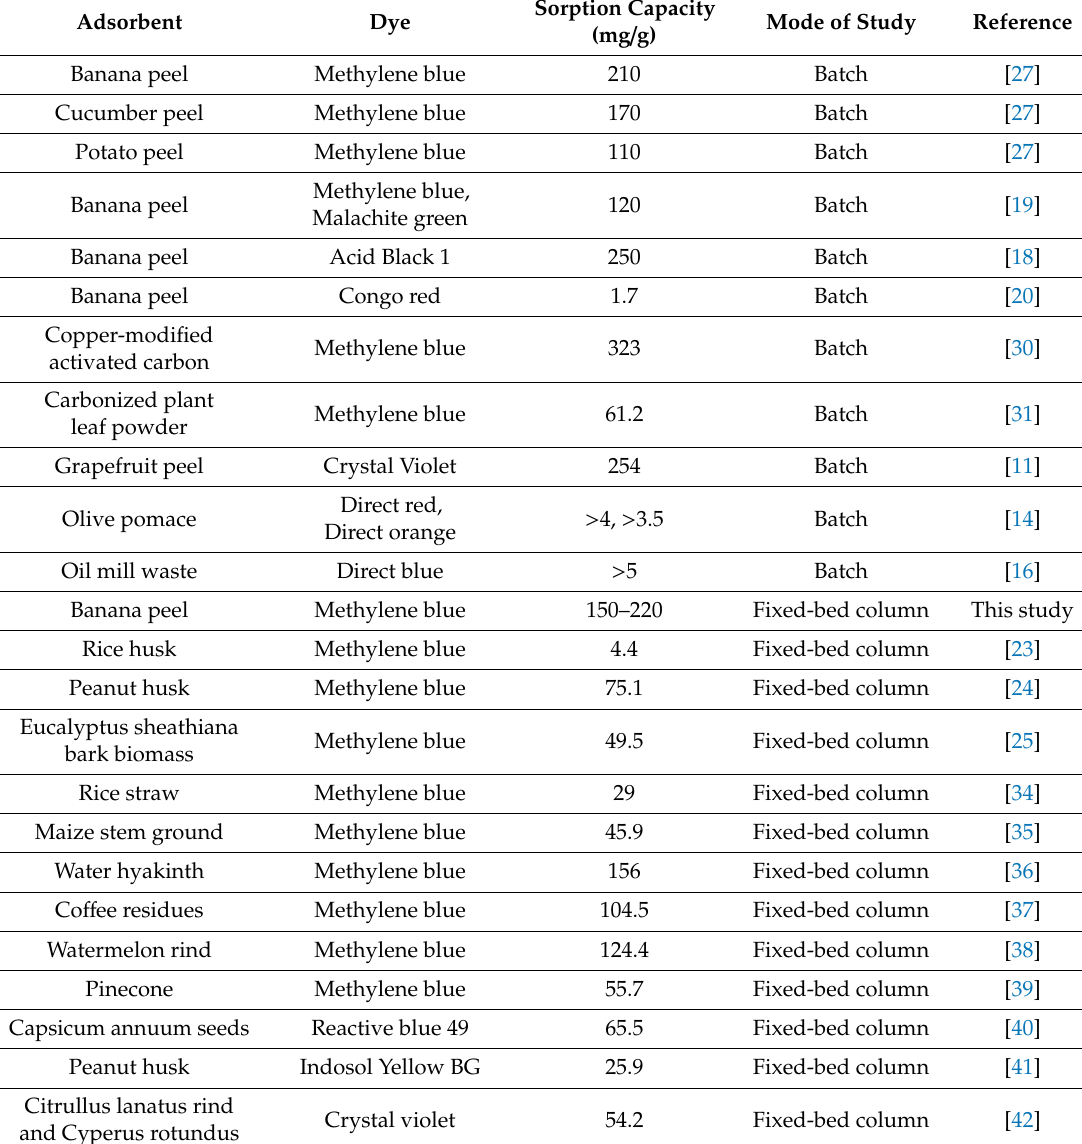
Table 1. Dye sorption capacity for banana peels and other